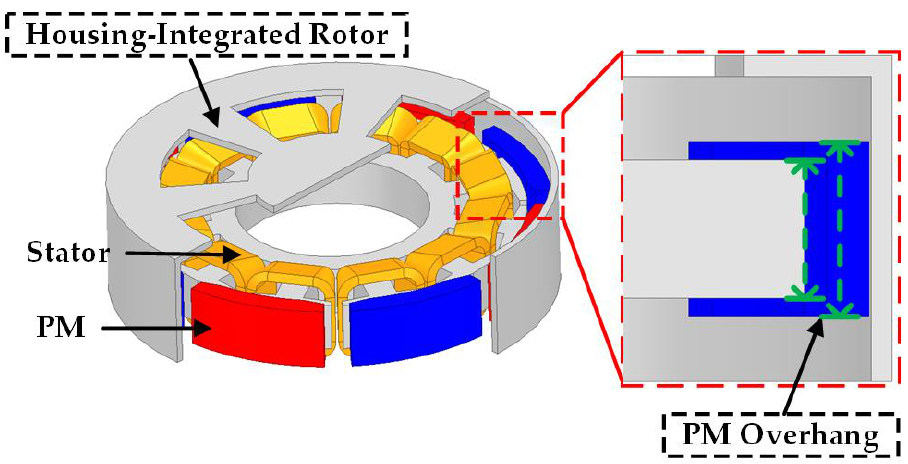
Figure 1. The 3D structures of the analysis model.